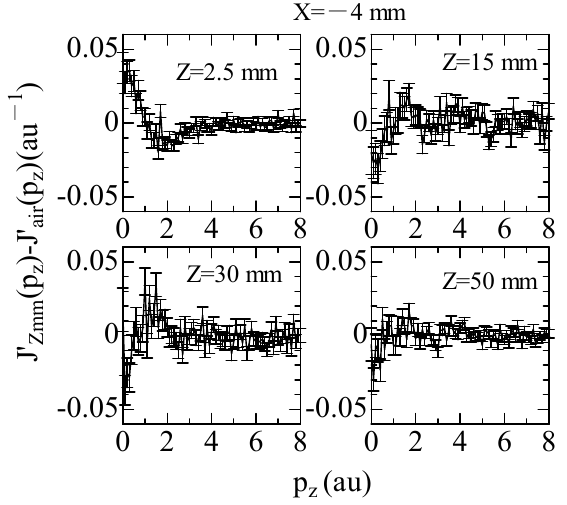
Figure 3. The difference of Compton profiles Δ J ( p z ) = J’ zmm ( p z ) − J’ air ( p z ). Here, J’ zmm ( p z ) denotes a normalized Compton profile J’ ( p z ) at z mm. J’ air ( p z ) denotes the normalized Compton profile of air.